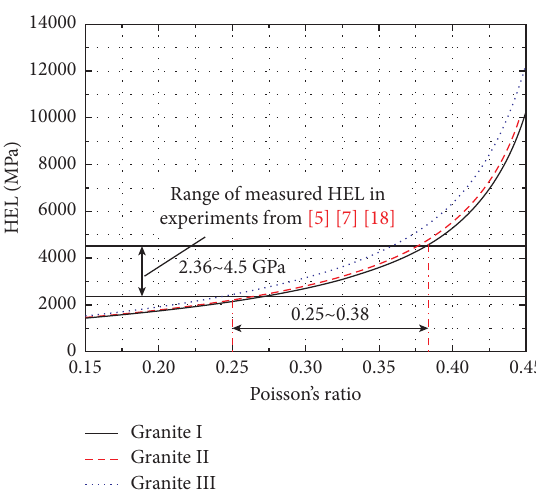
Figure 2: Comparison of calculated and measured HEL.